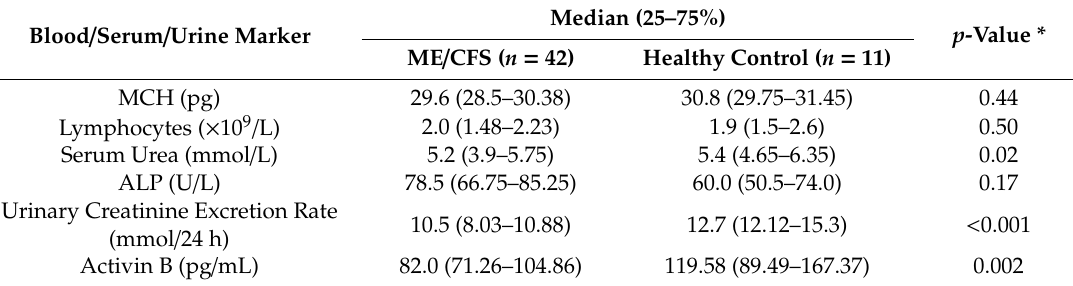
Table 5. Median and 25–75 IQR calculated from ME / CFS or healthy control cases correctly predicted by Random Forest Analysis (RFA). ME / CFS cases ranged from mild to severe symptoms, as determined by the International Consensus Criteria [12] and the standing test.